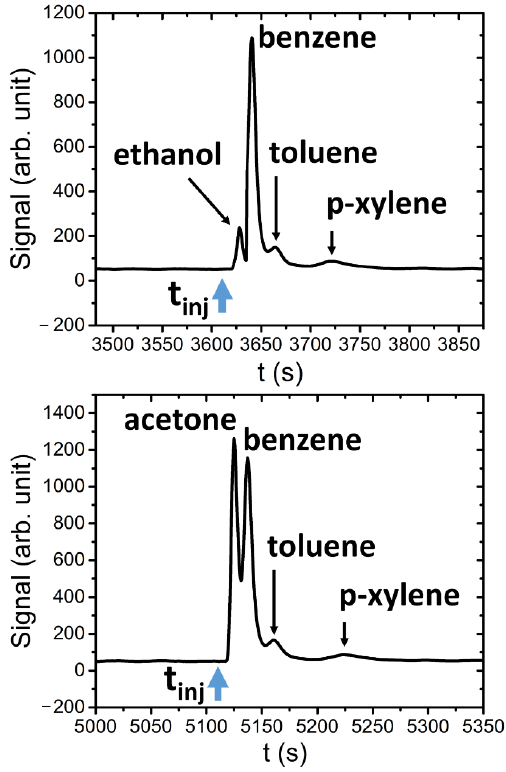
Figure 10. Example of two mixtures of ethanol, benzene, toluene and p-xylene (top graph) and acetone, benzene, toluene and p-xylene (bottom graph).